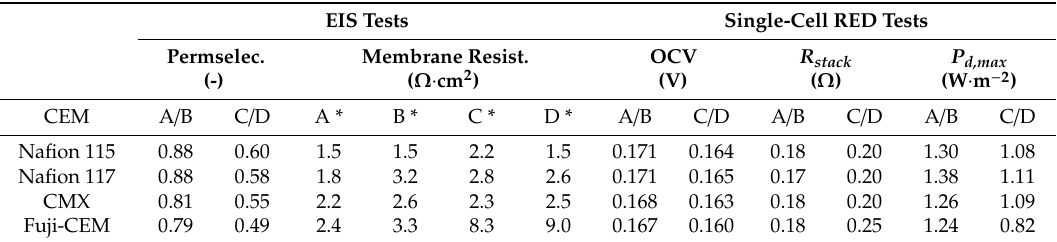
Table 3. Electrochemical characterization data from single-cell RED